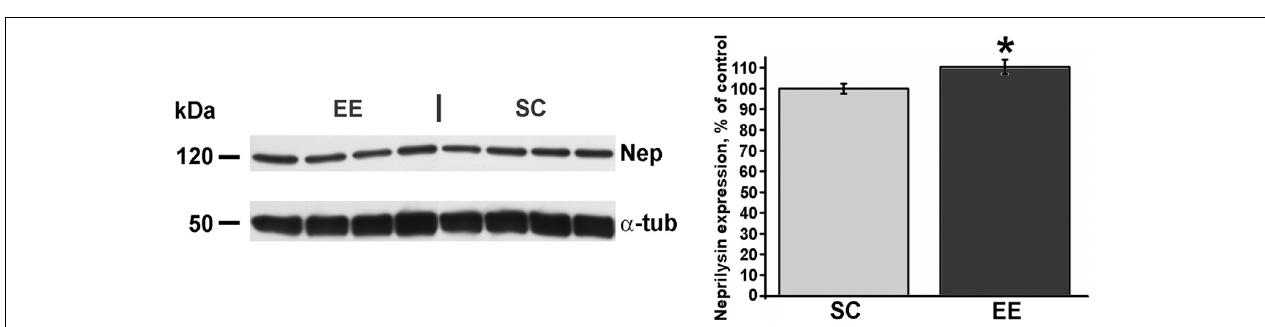
FIGURE 6 | Decrease of amyloid β oligomers in aged enriched mice. (A) Left, representative immunoblotting and right, quantification of the expression of A β oligomers probed with the A11 polyclonal antibody. (B) Left, representative immunoblotting and right, quantification of expression of A β